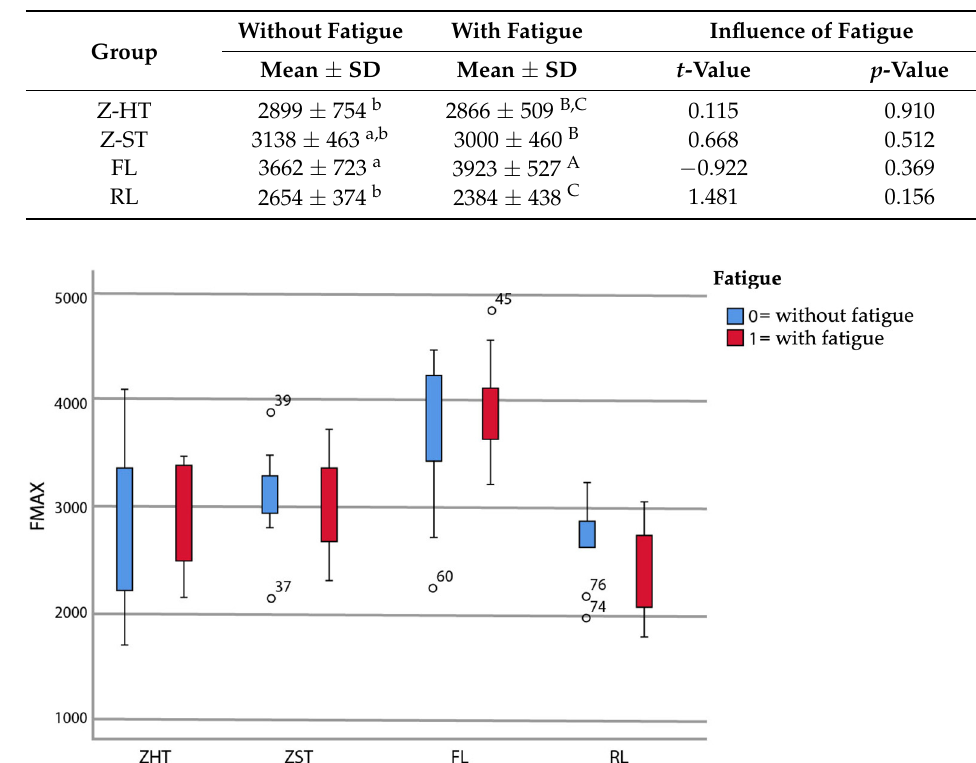
Figure 4. Boxplot of failure load values (in N).